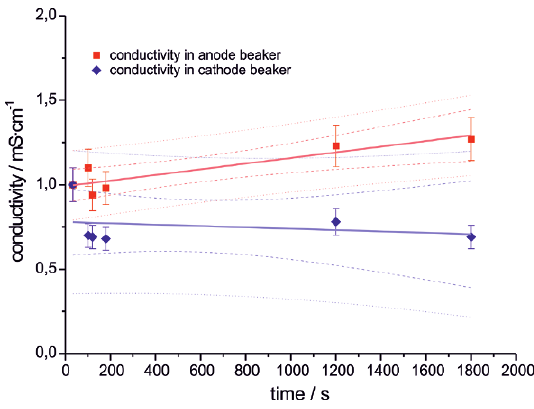
Figure 5. Exp. 1a: Transport of phenol from cathode to anodic beaker, conductivity measurement evaluated with a linear fit including 95% confidence (dashed) and 95% prediction (dotted) intervals.